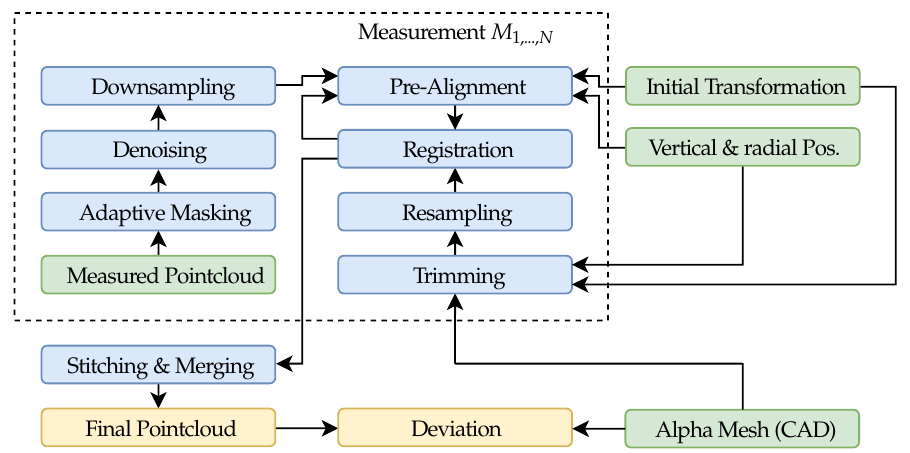
Figure 8. Flowchart of all significant data processing operations (green: input, blue: data processing, orange: